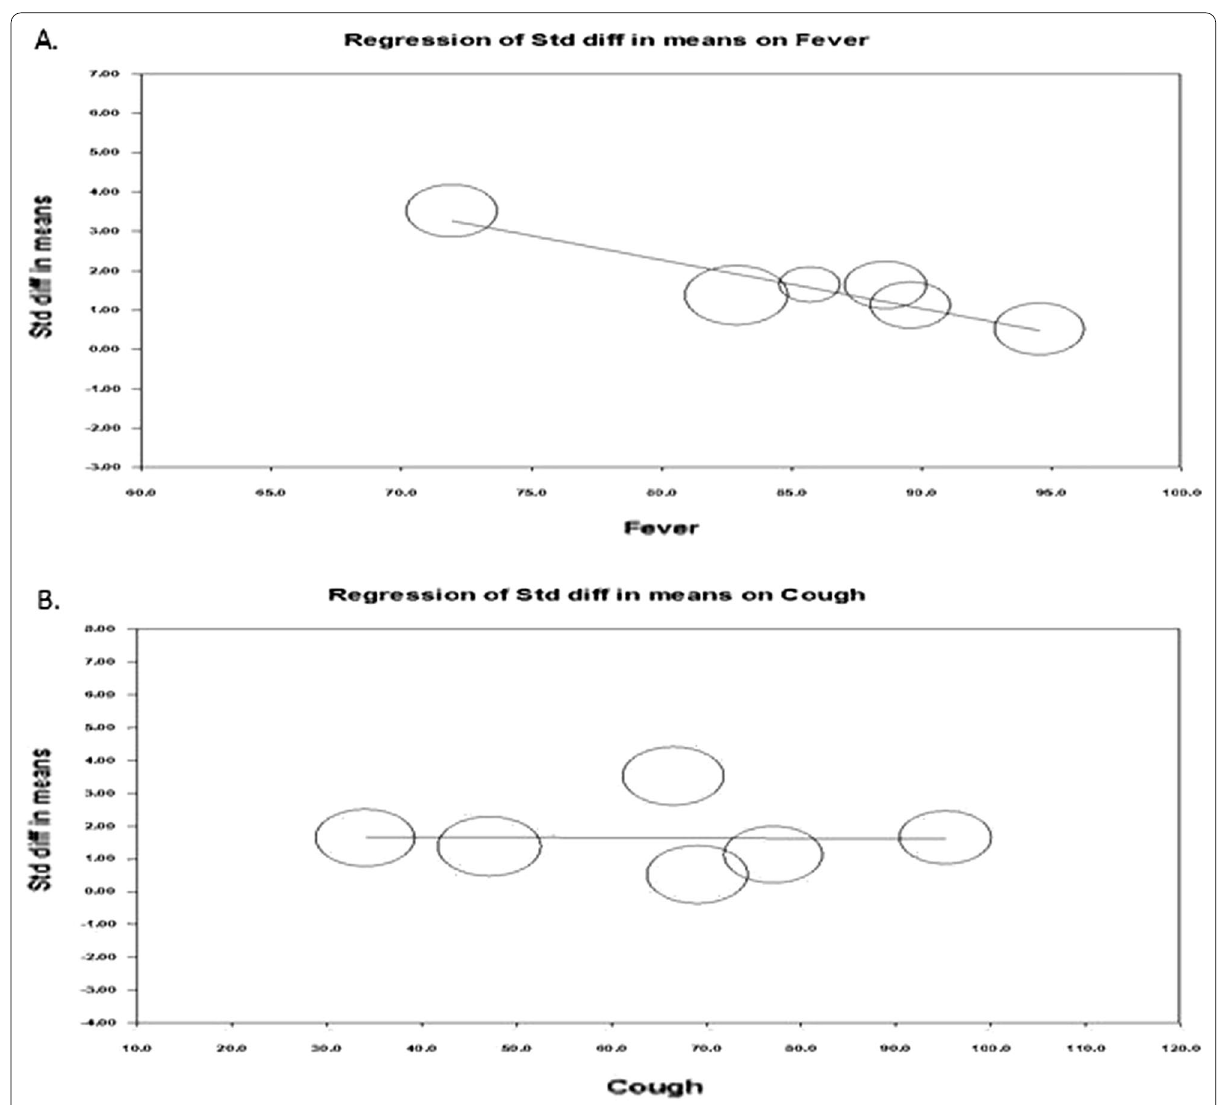
Fig. 4 Regressin analysis of effect size on covariates fever rate ( A ) and cough rate ( B